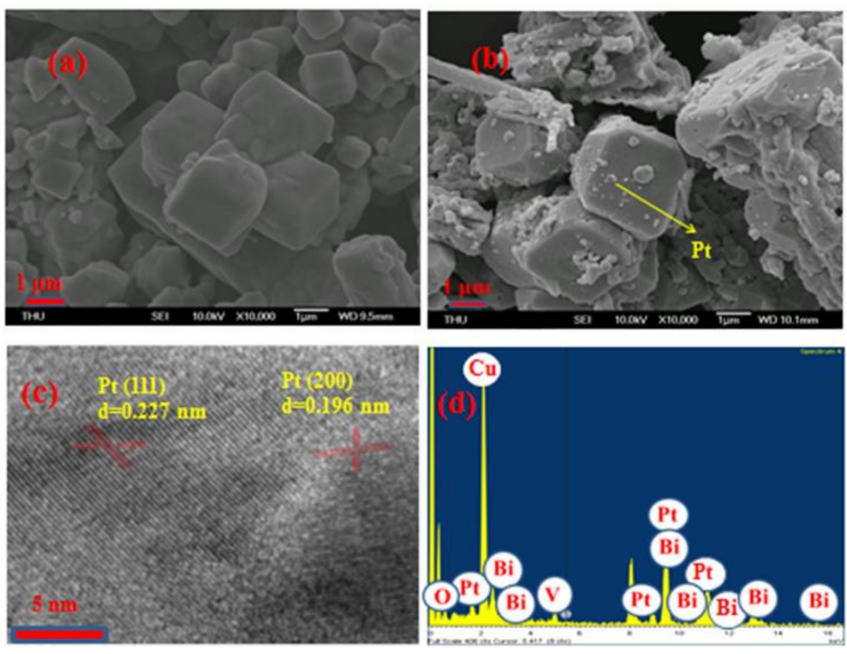
Figure 3. ( a ) FESEM images of BiVO 4 ( b ) Pt/BiVO 4 ; ( c ) TEM images of Pt/BiVO 4 ( d ) EDS spectrum of 3wt.% Pt/BiVO 4 nanocomposites.